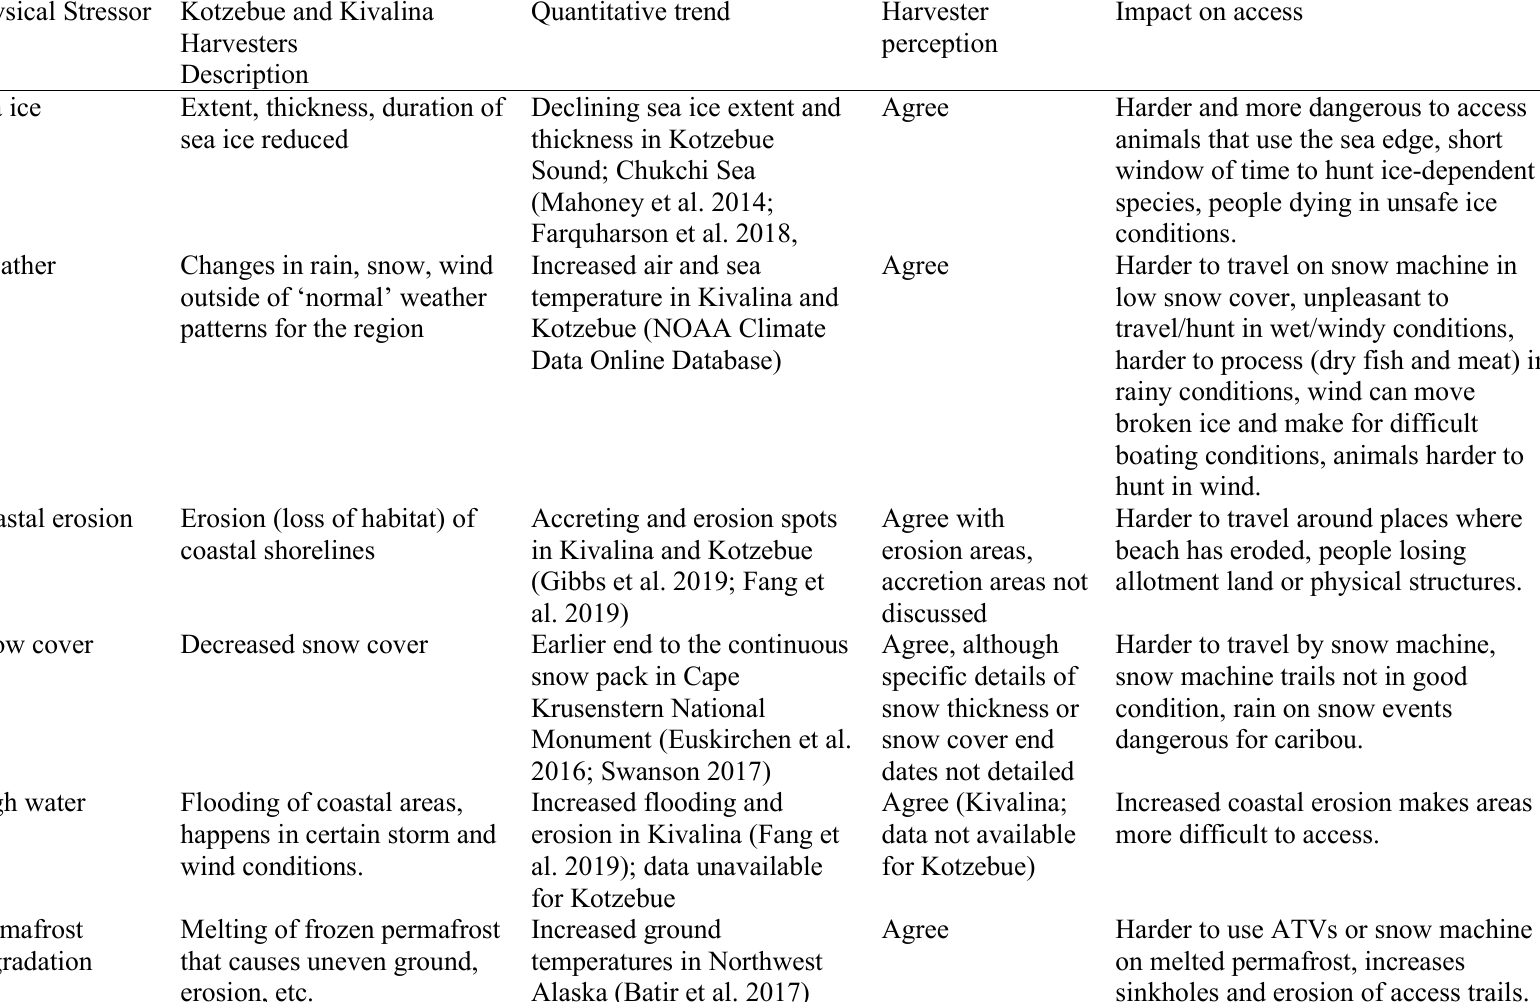
Table A2 . 1 Description of climate stressors, and potential impacts to harvesting subsistence resources as reported by